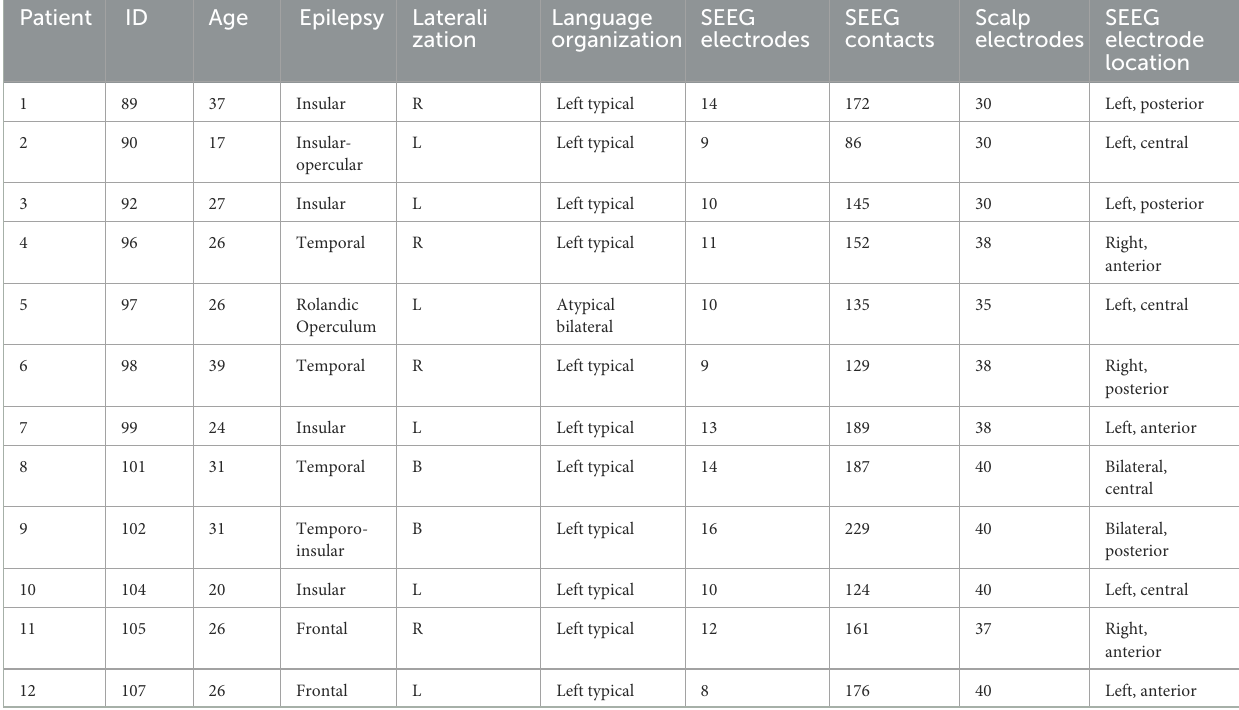
TABLE 1 Patients included in this